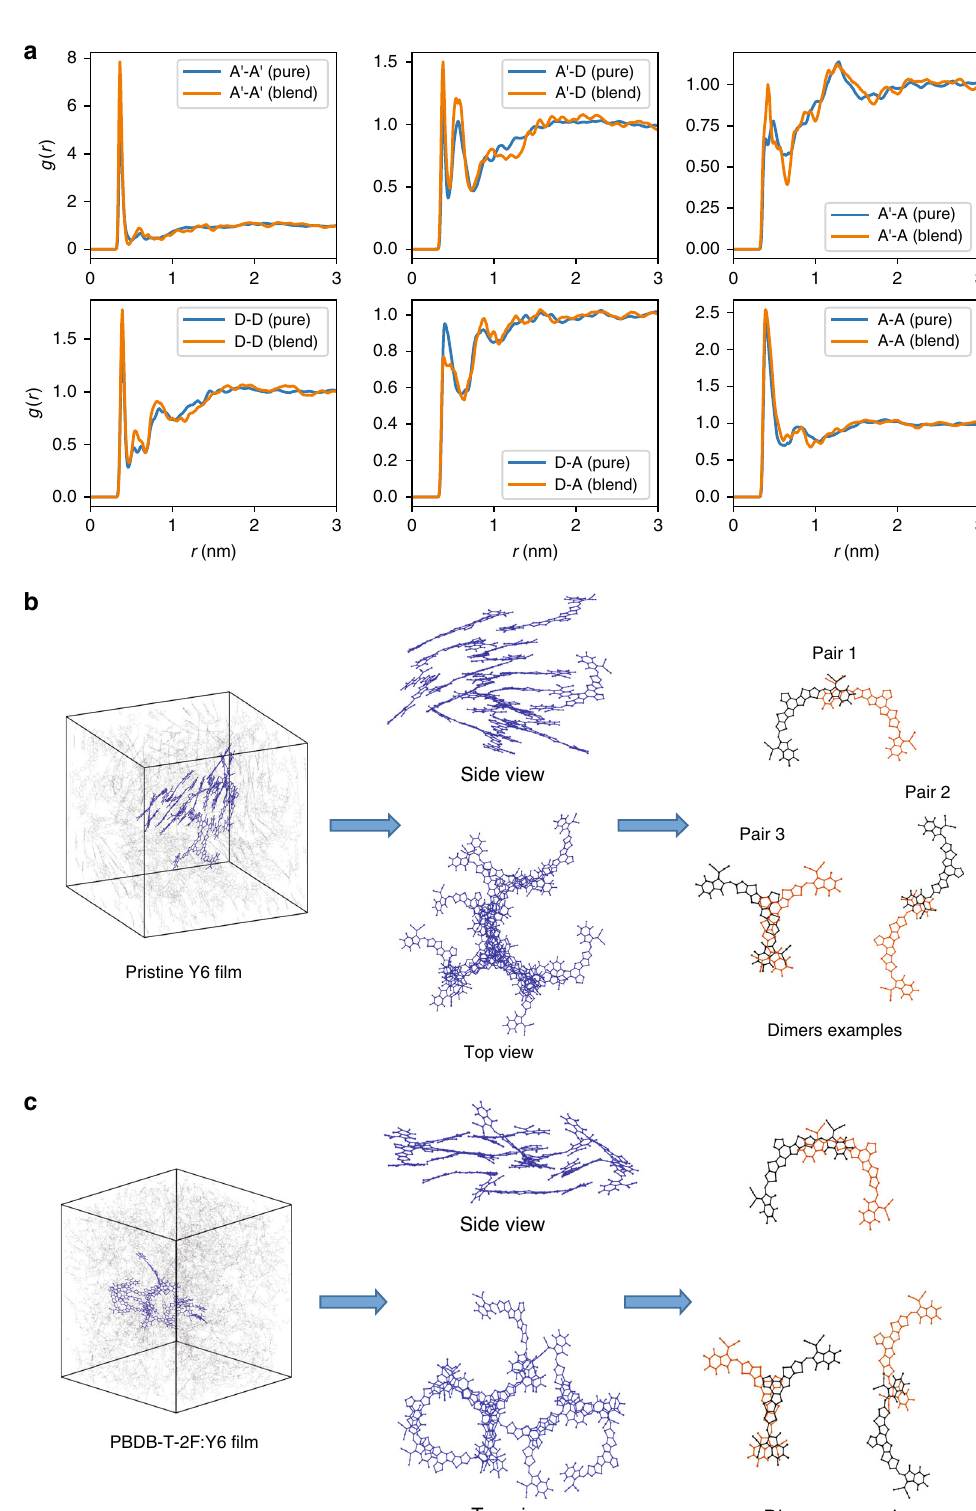
Fig. 3 Molecular-dynamics (MD) simulations of Y6 based systems. a – c Radial distribution function ( g ) data for Y6 ( a ). The labels for the acceptor moieties are shown in Fig. 1a. The blue lines represent the data from the pristine acceptor fi lms and the orange lines, the data from the donor/acceptor blends. Illustration of the molecular-dynamics simulations results for the packing in b the pristine Y6 and c PBDB-T-2F:Y6 fi lms. A signi fi cant amount of Y6 dimers in both the pristine and blended fi lms show similar packing compared to the Y6 crystal